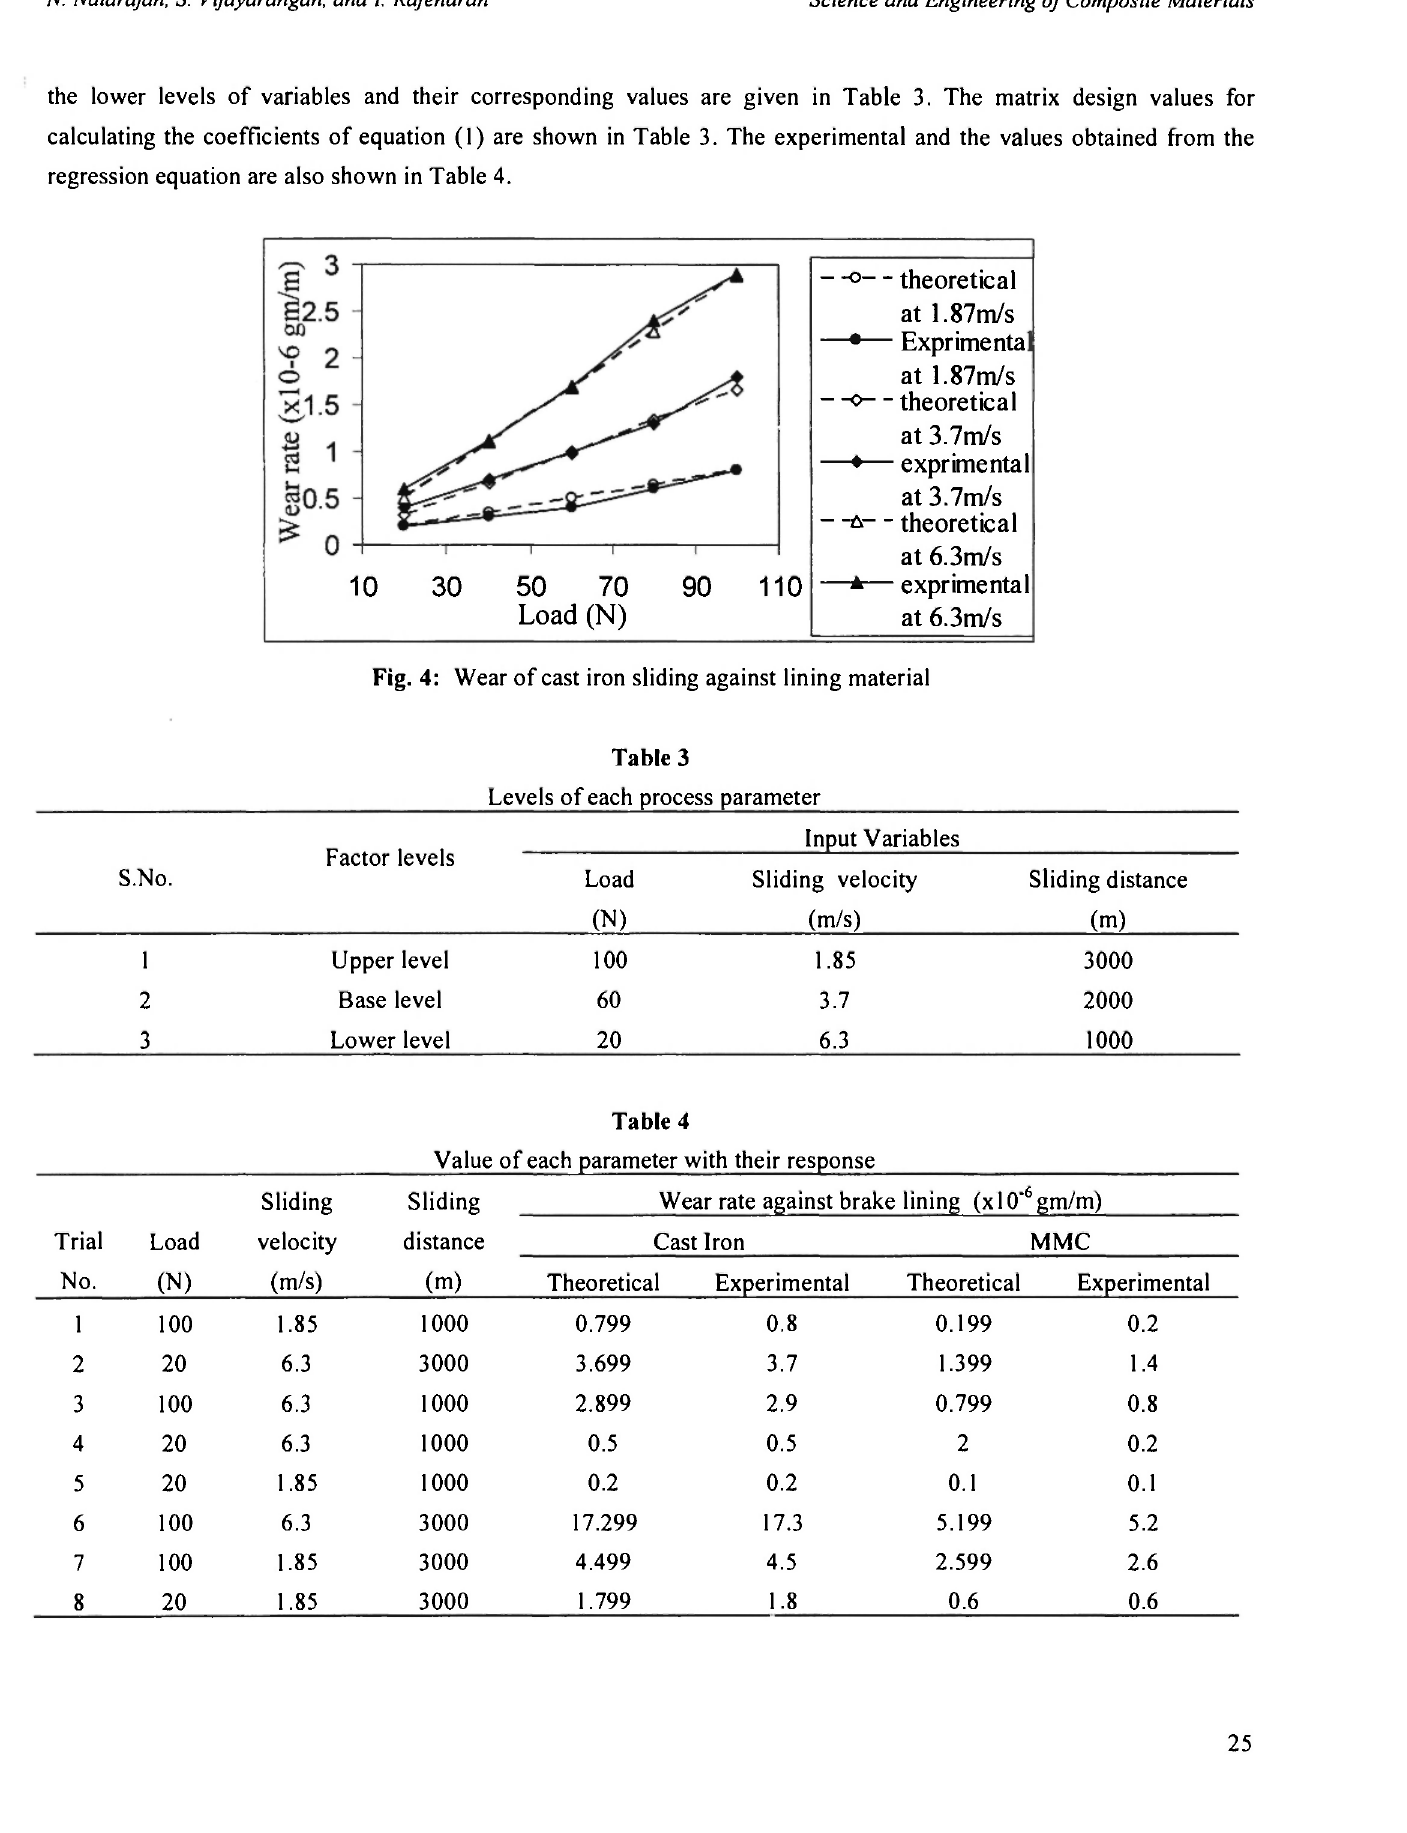
Fig. 4: Wear of cast iron sliding against lining material